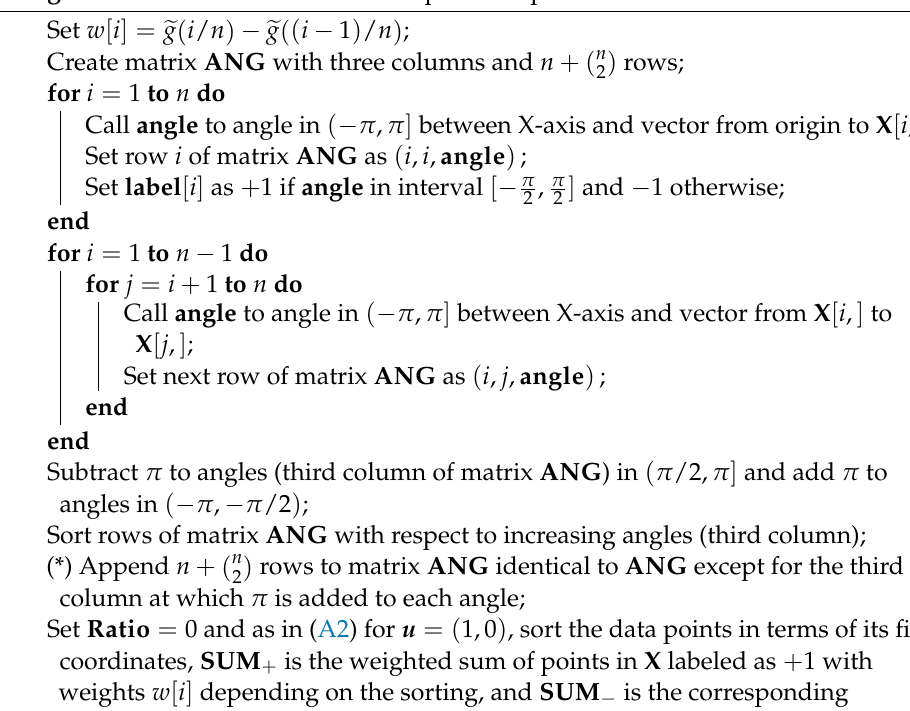
Algorithm A1: Bivariate distorted expectile